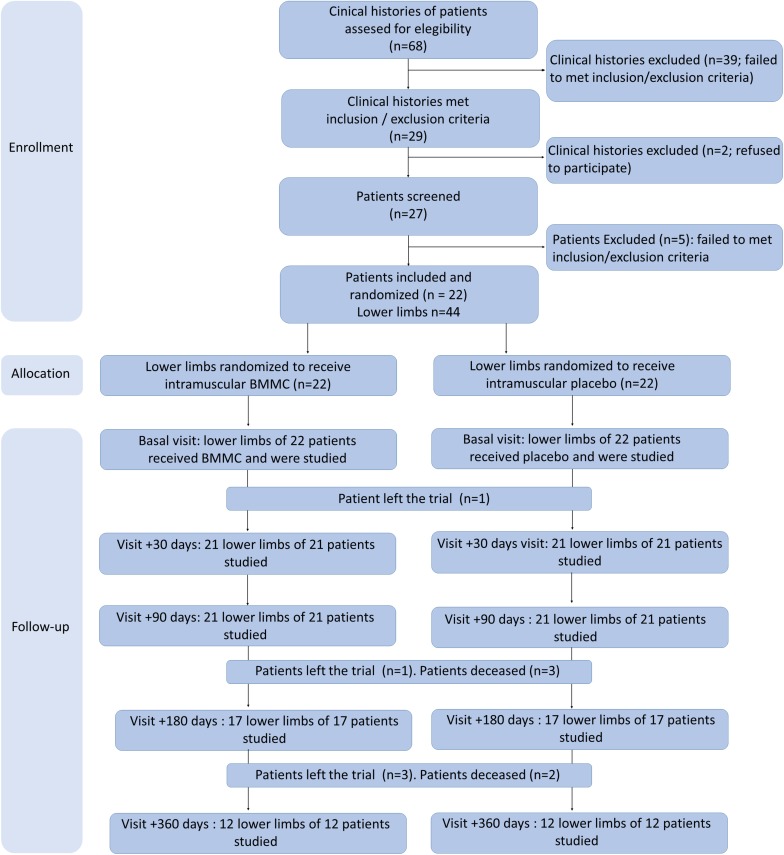
Flowchart of the study. It was impossible to complete the EMG study in some patients, or some data could not be recovered: for this reason, the number of cases shown in the figures may not be the same as the number of patients examined at each visit.